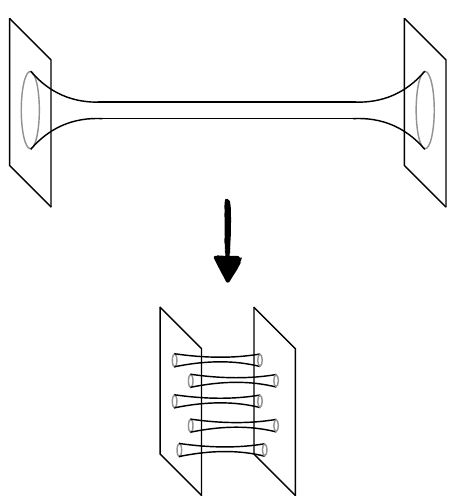
Figure 6 . On top we have the (near-extremal) black brane, connected by a very long wormhole whose length diverges in the extremal limit. The WGC triggers an instability and the black brane decays to a myriad of \Planck-sized wormholes", which are presumably OK with